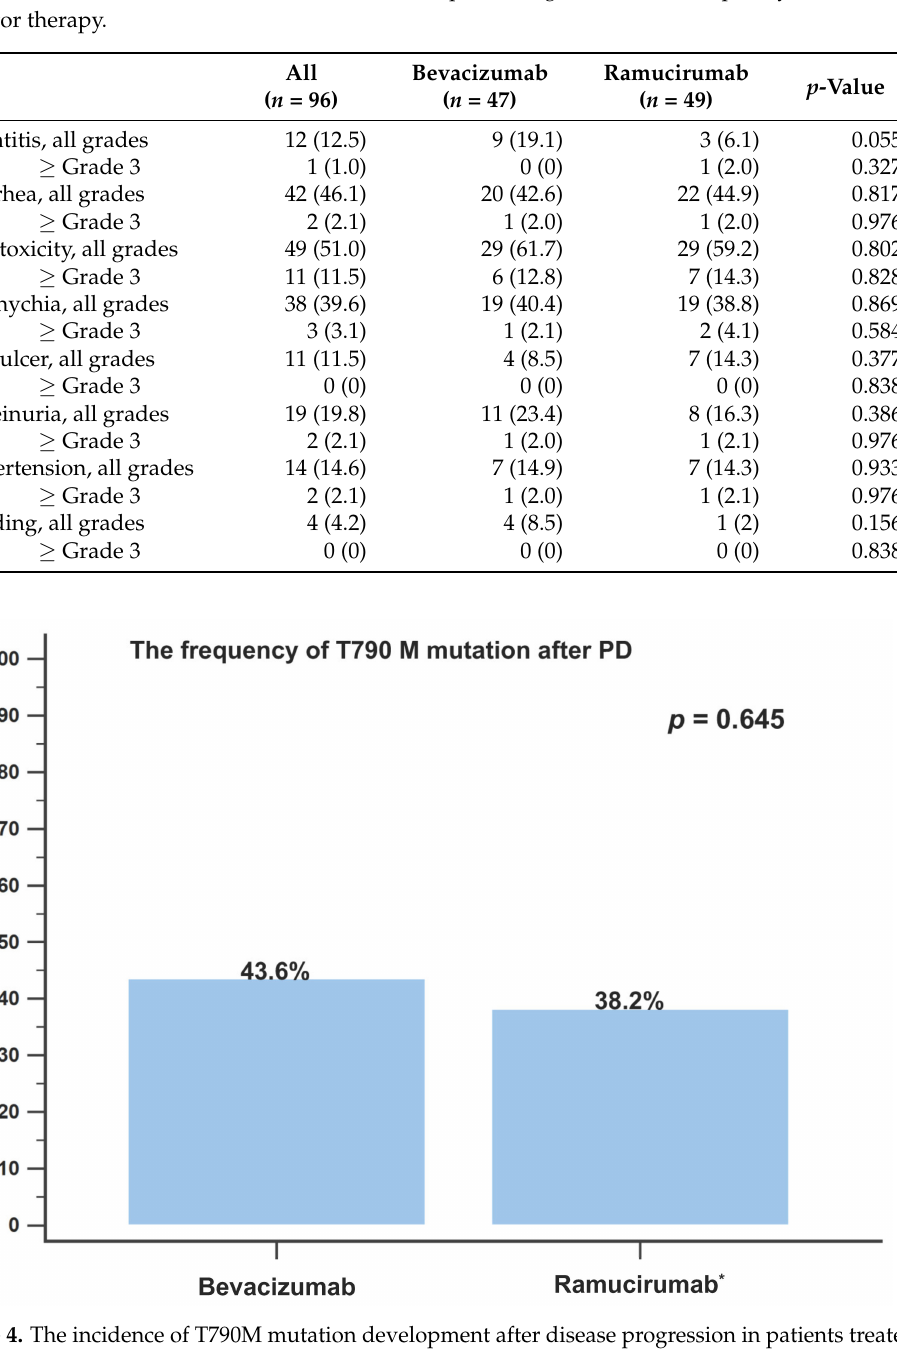
Figure 4. The incidence of T790M mutation development after disease progression in patients treated with bevacizumab or ramucirumab combination therapy. PD, progressive disease. * Patients treated with osimertinib were